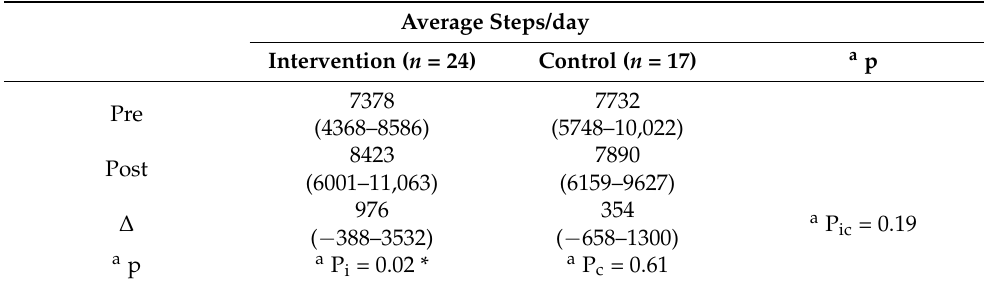
Table 2. Average steps/day of participants before and after the 16-week intervention, representing the quantity of free-living ambulatory behavior.